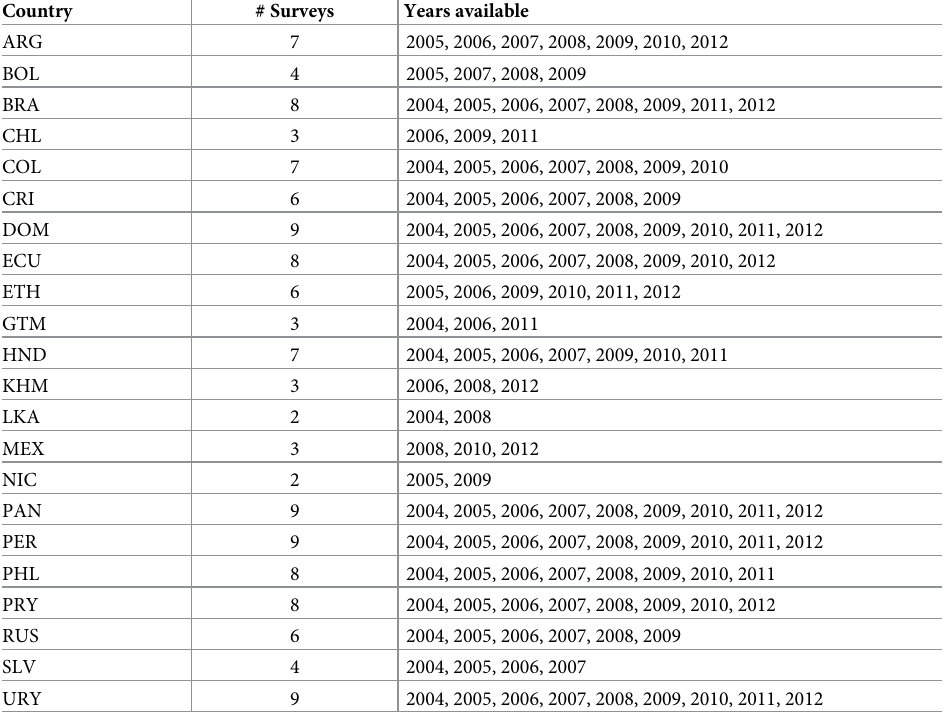
Table 1. List of the countries and survey years. Country #